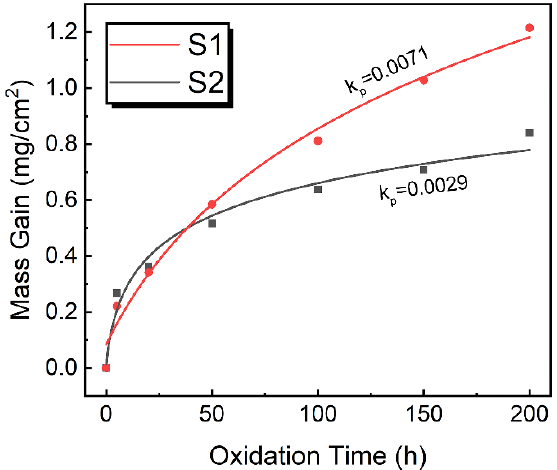
Figure 4. Oxidation kinetics curves of two ODS alloys.